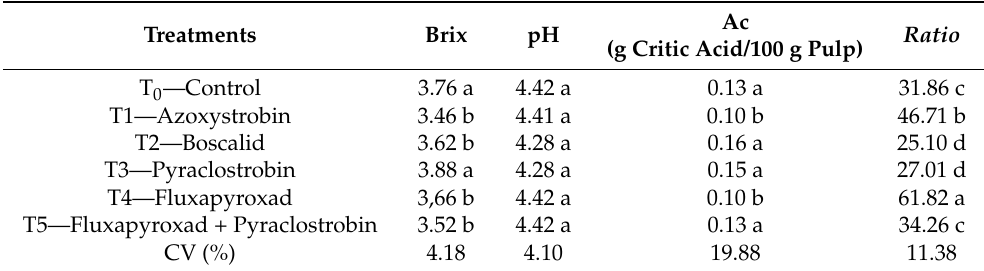
Table 5. Soluble solids content ( ◦ Brix), pH (pH), titratable acidity (Ac) and the ratio between ◦ Brix and acidity ( Ratio ) of tomato fruits treated with fungicides with physiological effect.